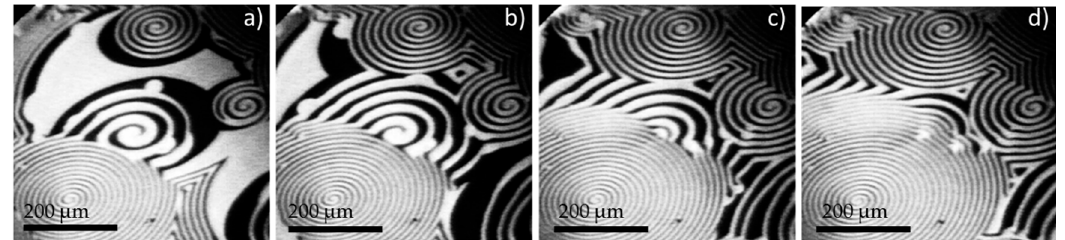
Figure 5. PEEM study of surface reaction and spatiotemporal patterns formation: Temporal evolution of diffusion patterns during the oxidation of CO on Pt surface. Conditions of acquisition: T = 448 K, P O = 4 × 10 − 4 Pa, P CO = 4.3 × 10 − 3 Pa. Reprinted from [158]. Copyright 1993, AIP Publishing.